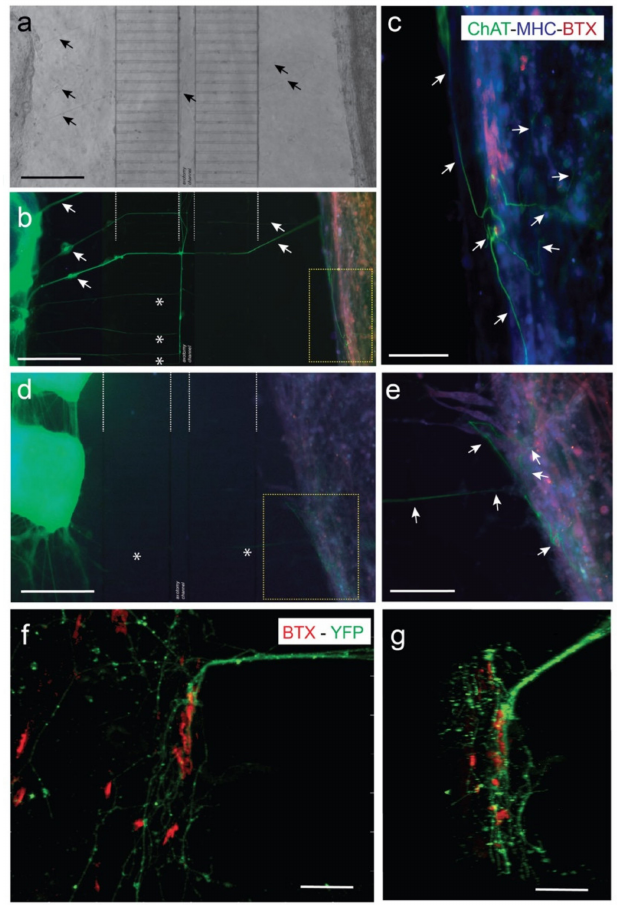
Figure 3. Examples of NMJ formation in our microfluidic devices (MFDs). ( a , b ) A low power photomicrograph of the axotomy-assisted device is shown in ( a ). A parallel triple fluorescence image after the immunohistochemical (IH) protocol of the device shown in ( a ) can be seen in ( b ). A high magnification image of the yellow square in ( b ) can be seen in ( c ). This device was immunostained using ChAT antibodies to demonstrate the presence of MN-derived axons in the C2C12 myotube chamber. In addition, cultured cells in the device were also immunostained using MHC antibody (blue) and incubated with BTX-Alexa Fluor-595 (red). ( d , e ) Low ( d ) and high ( e ) magnification photomicrographs of a parallel device similar to ( a – c ), using the same antibodies. In this example, two pieces of the ventral horns (left) of the dissected spinal cord can easily be observed in (d). Arrows (black in a) and (white in (b)) are included as reference marks between the two images. In addition, asterisks in ( b , d ) also label reference microchannels. Arrows (white in (c,e)) point to ChAT-positive axons entering into the C2C12 myotubes. ( f , g ) Confocal microscopy images of double labelled (BTX-Alexa Fluor-595 and eYFP) photomicrograph illustrating the location of the eYFP-labelled MN axons (expressing ChR2-eYFP) running over the di ff erentiated myotubes showing BTX-Alexa Fluor-595 labeled spots. A z stack animation of the image shown in ( f ) may be observed in Supplementary Video S5. Scale bars: (a,b,d) = 400 mm, (c,e) = 200 mm, (f) = 70 mm, (g) = 30